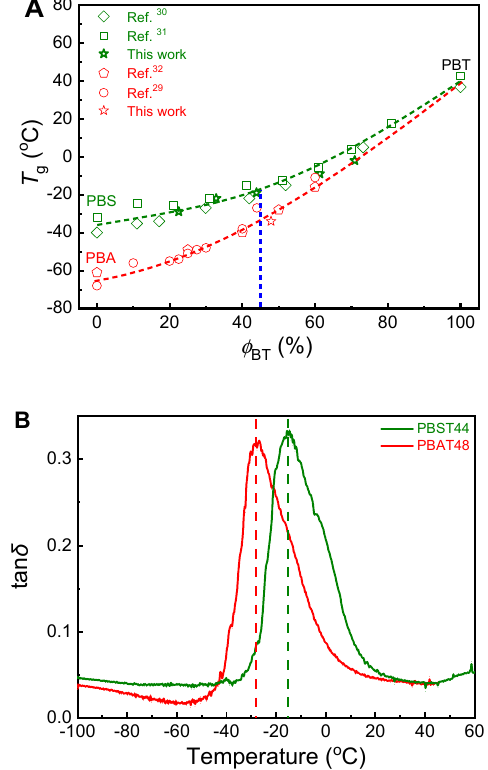
Figure 6. ( A ) Composition dependence of glass transition temperature (measured from DSC) of PBST and PBAT copolyesters, data from refs. [29–32]; ( B ) tan δ of PBAT48 and PBST44 in temperature range of − 100 ◦ C to 60 ◦